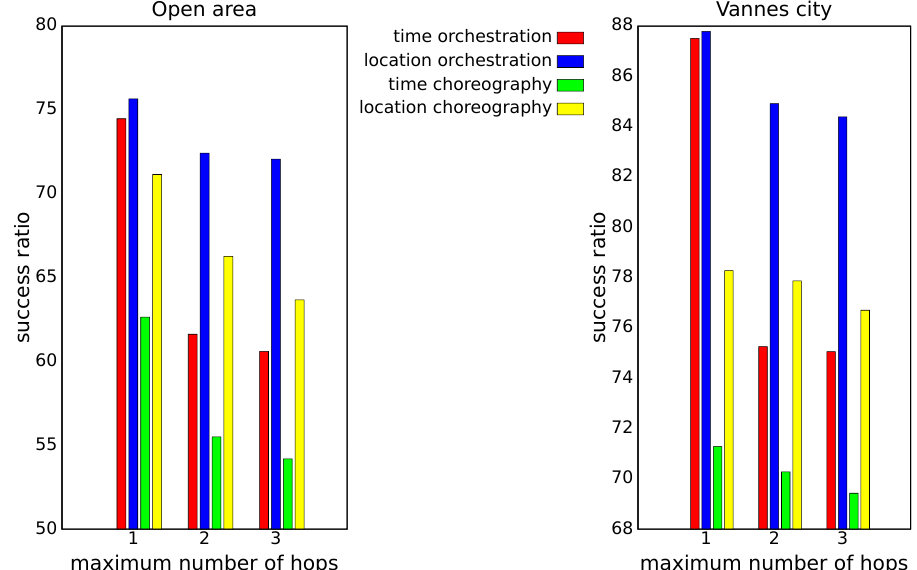
Figure 4. Success ratio against the maximum number of hops between service clients and service